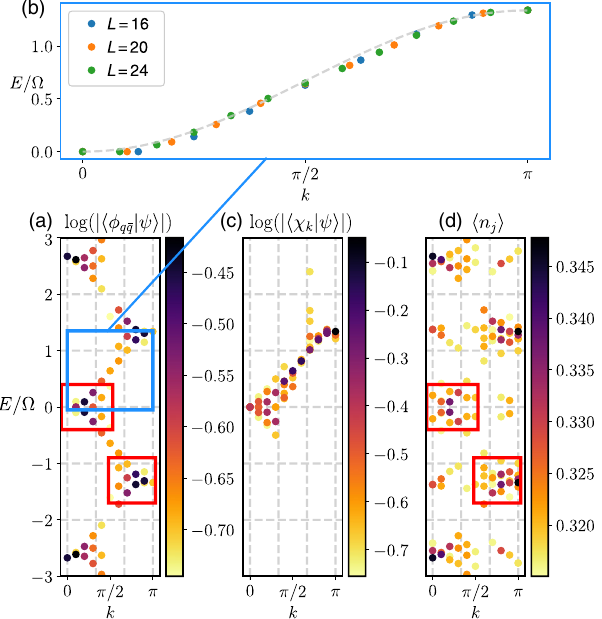
FIG. 7. Emergent quasiparticle description of highly excited states. (a) Largest overlaps of the initial state j ϕ q ¯ q i with a localized defect in a charge-density wave configuration of the Rydberg atom chain with the energy eigenstates j ψ i of the FSS Hamiltonian ( δ ¼ 0 , L ¼ 20 ) in Eq. (2), as a function of their corresponding momentum and energy. Within the gauge-theory description, the initial state corresponds to having a localized particle-antiparticle pair q − ¯ q . (b) The eigenstates with the largest overlaps display a regular functional dependence of energy on momentum that is remarkably close to a simple cosine band. (c) The largest overlaps of the optimal matrix-product state quasiparticle ansatz j χ k i built on an exact eigenstate with zero energy (see the main text) accurately reproduce the corresponding emergent quasiparticle band of (a). (d) Anomalous (nonthermal) expectation values of a local observable in energy eigenstates. The red boxes highlight the correspondence between the most relevant eigenstates building up j ϕ q ¯ q i (a) and the most non- thermal eigenstates (d). The emergent spectral structure illus- trated here underlies the clean ballistic spreading of particle- antiparticle pairs displayed in Fig.